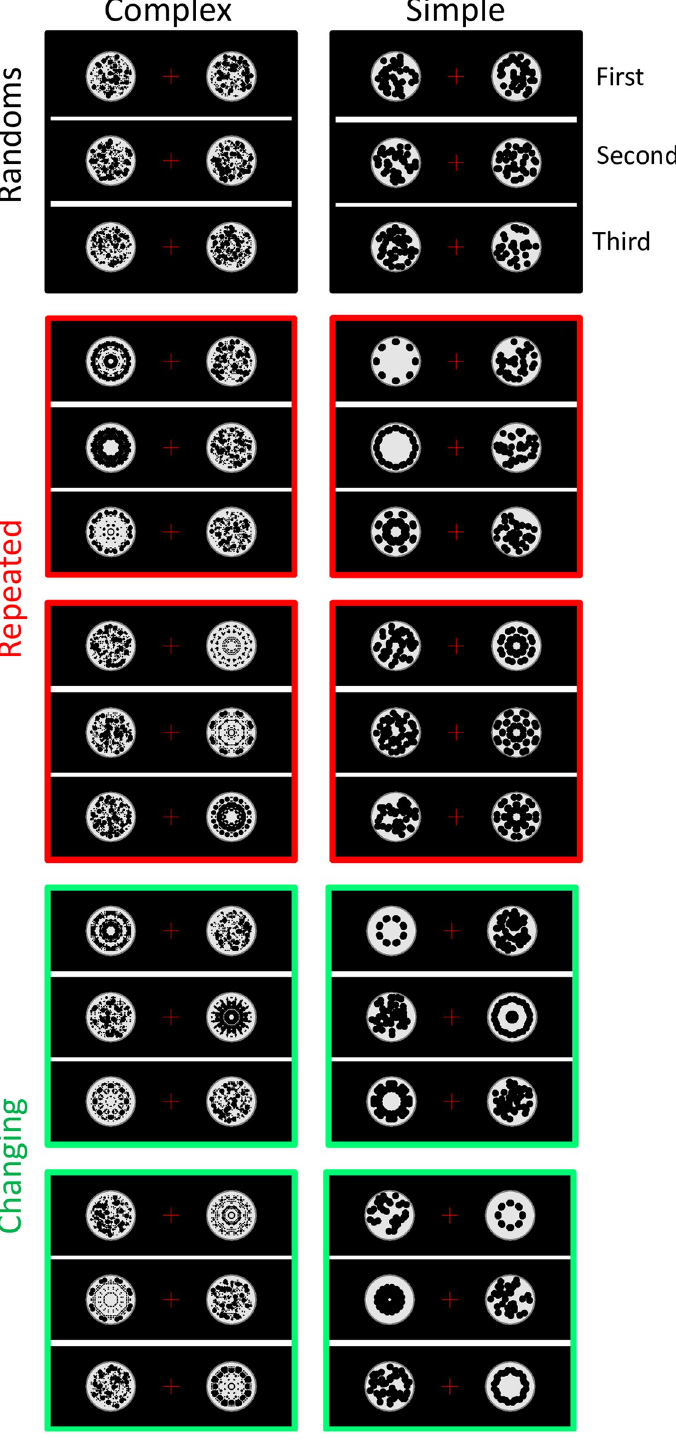
Fig 5. Experiment 2 stimuli. Each triplet had three pairs, with one pattern on the left of fixation, and one on the right of fixation. 24 participants were presented with complex pattern pairs (left column) and another 24 were presented with simple pattern pairs (right